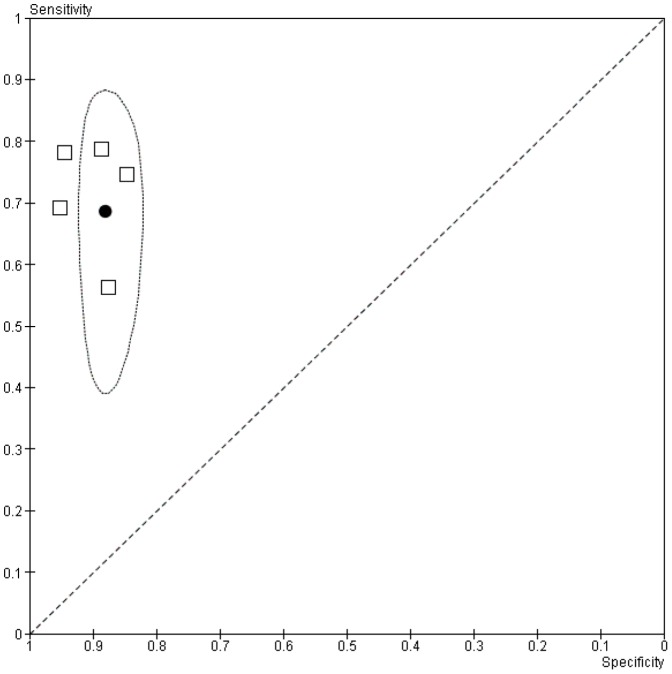
Sensitivity and specificity estimates for Tubex TF (open squares) with control group category 1 together with average sensitivity and specificity estimate (filled circle) and 95% confidence region.